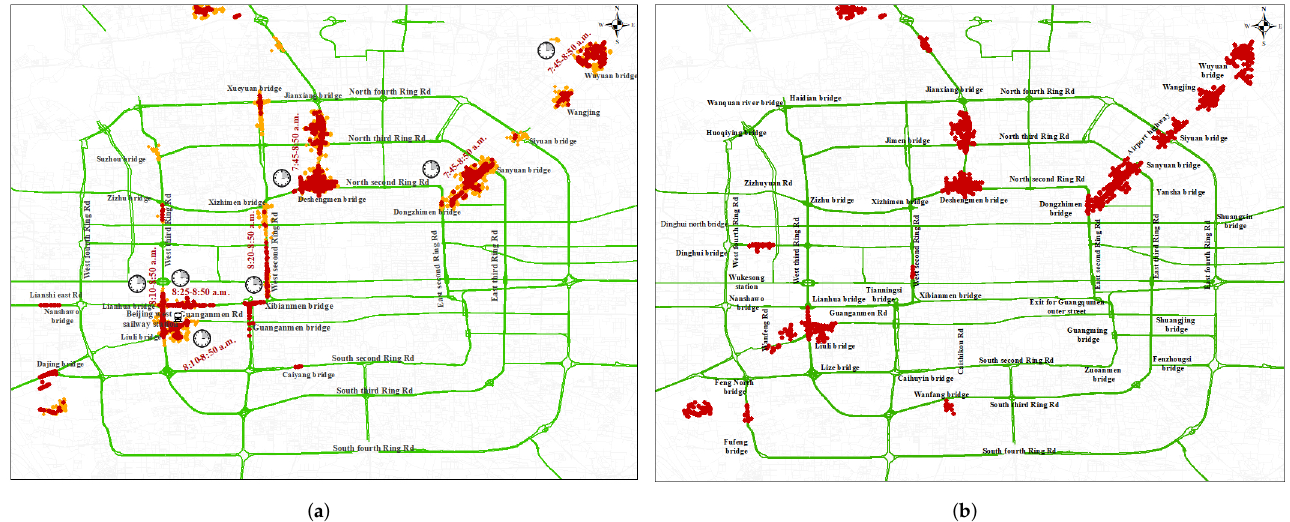
Figure 7. The discovered congested pattern between 7:00 and 9:00 a.m. on weekends. ( a ) The LMCPs generated by our algorithm; ( b ) The swarm pattern generated by CLUR